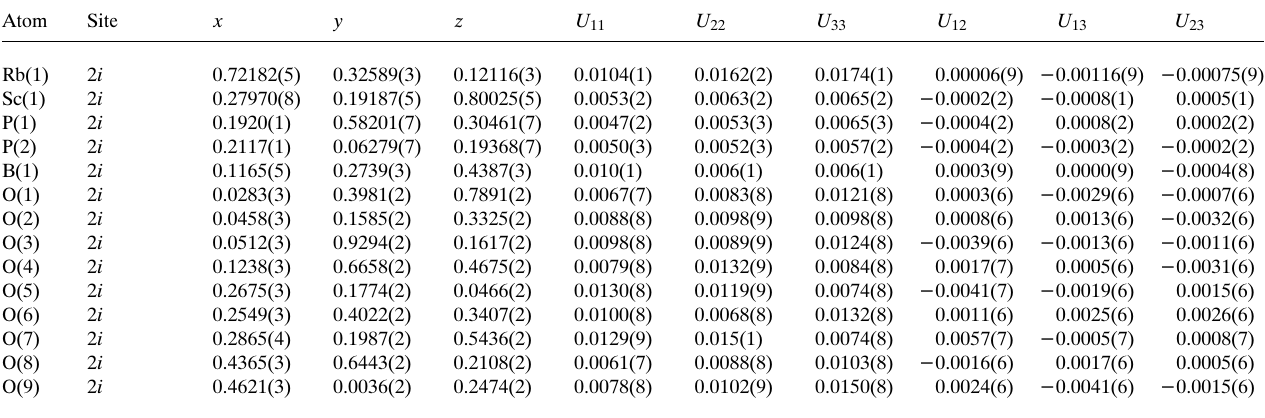
Table 3. Atomic coordinates and displacement parameters (in Å 2 )